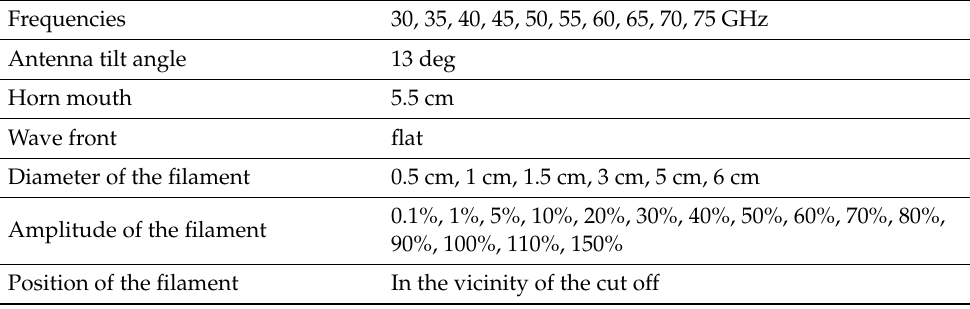
Table 4. Parameters of the performed modelling for the strip filament.